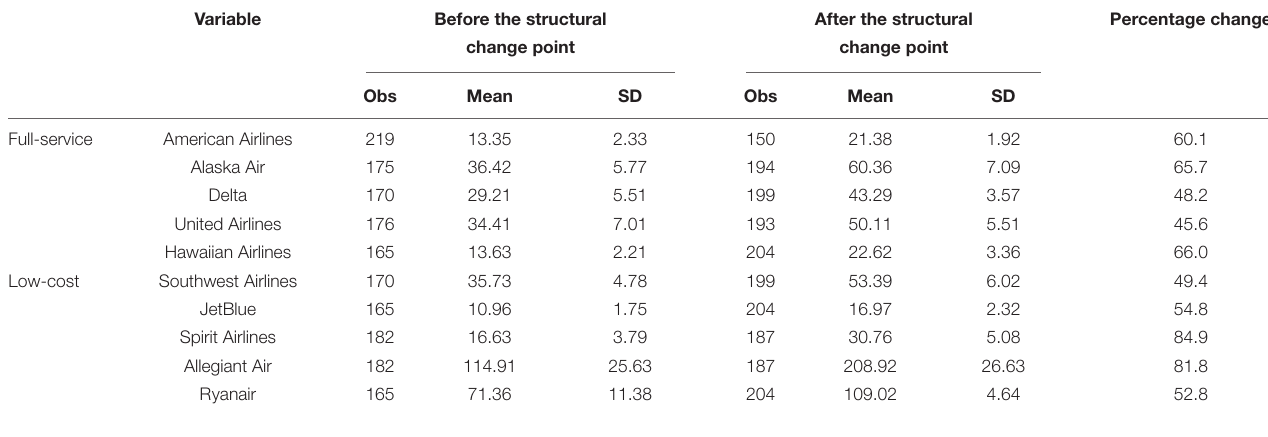
TABLE 2 | Descriptive statistics of stock prices before and after structural change unit: USD. Variable Before the structural After the